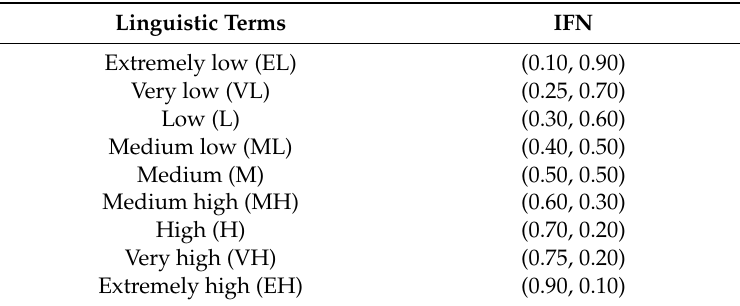
Table 3. Linguistic terms for assessing failure